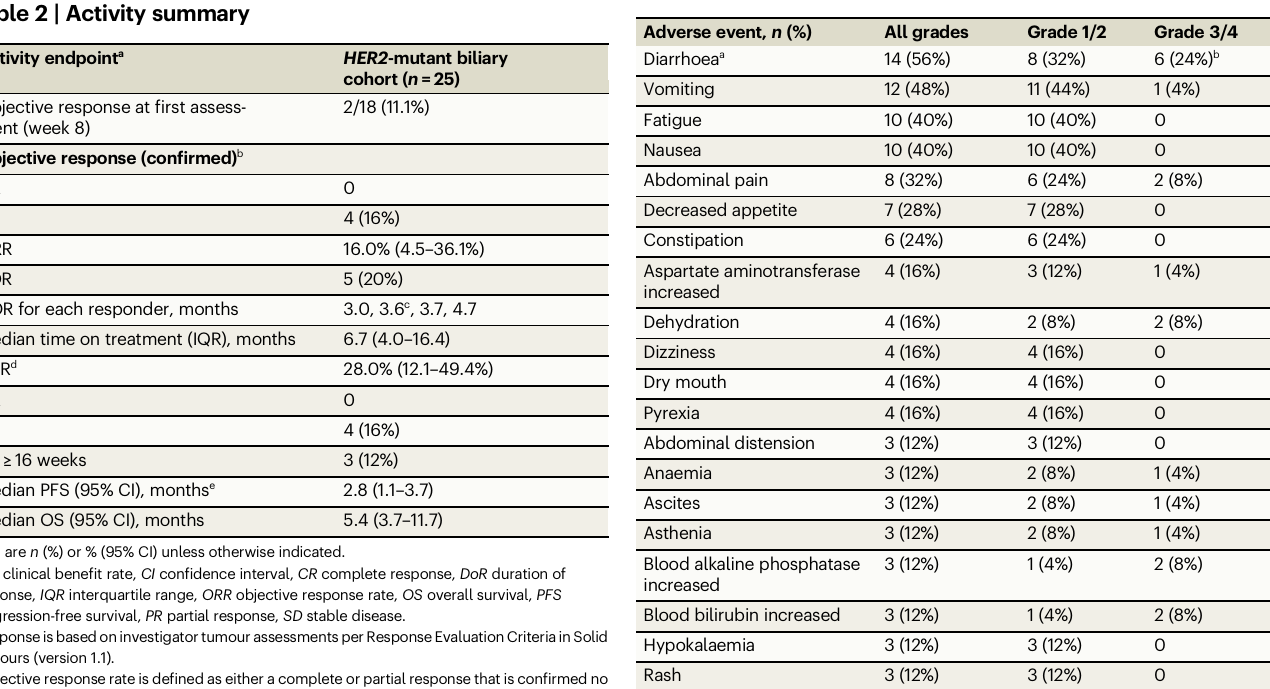
Table 3 | Incidence of treatment-emergent adverse events (occurring in ≥ 10% of patients) ( n =